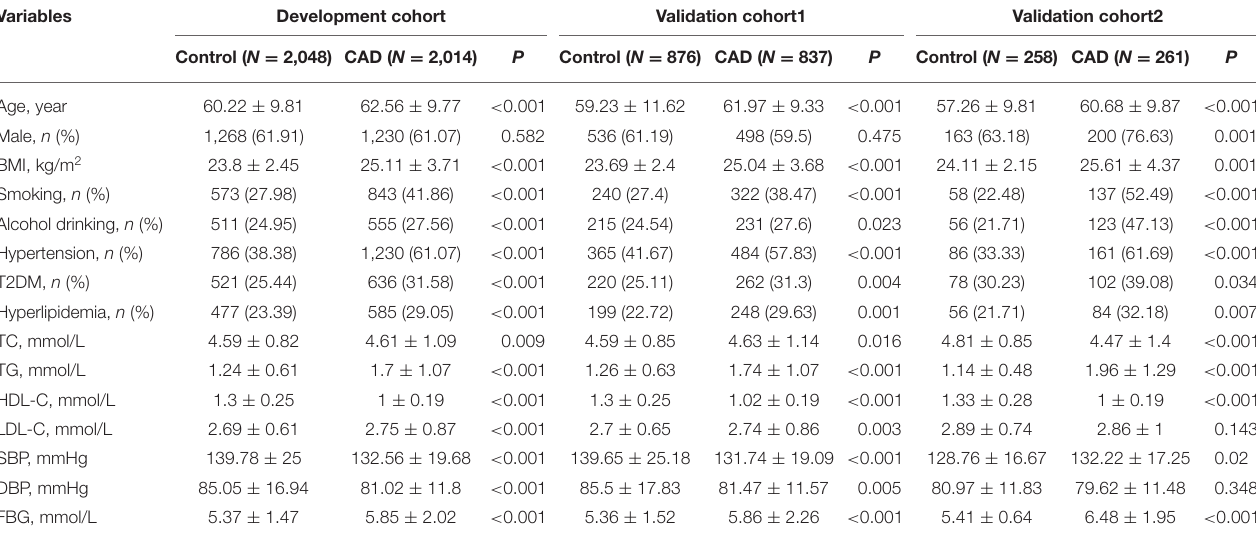
TABLE 1 | Baseline and clinical characteristics of the study cohort.